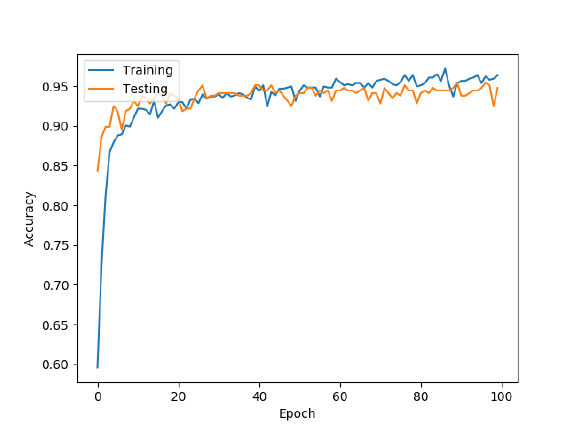
Figure 2. Accuracy behavior.